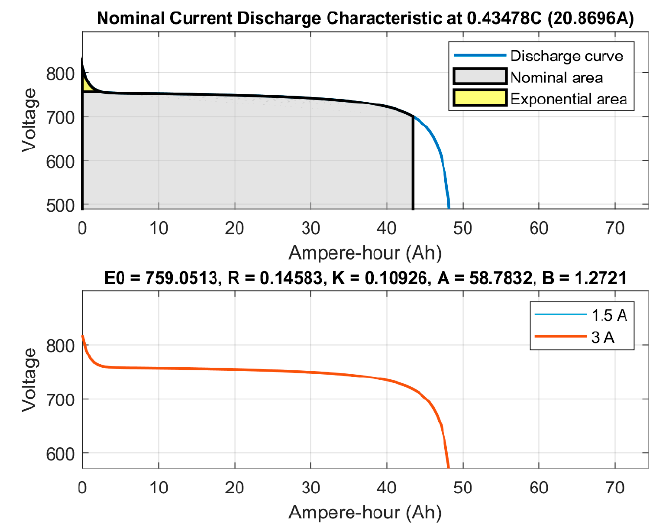
Figure 3. Discharging characteristics of the considered lithium-ion.